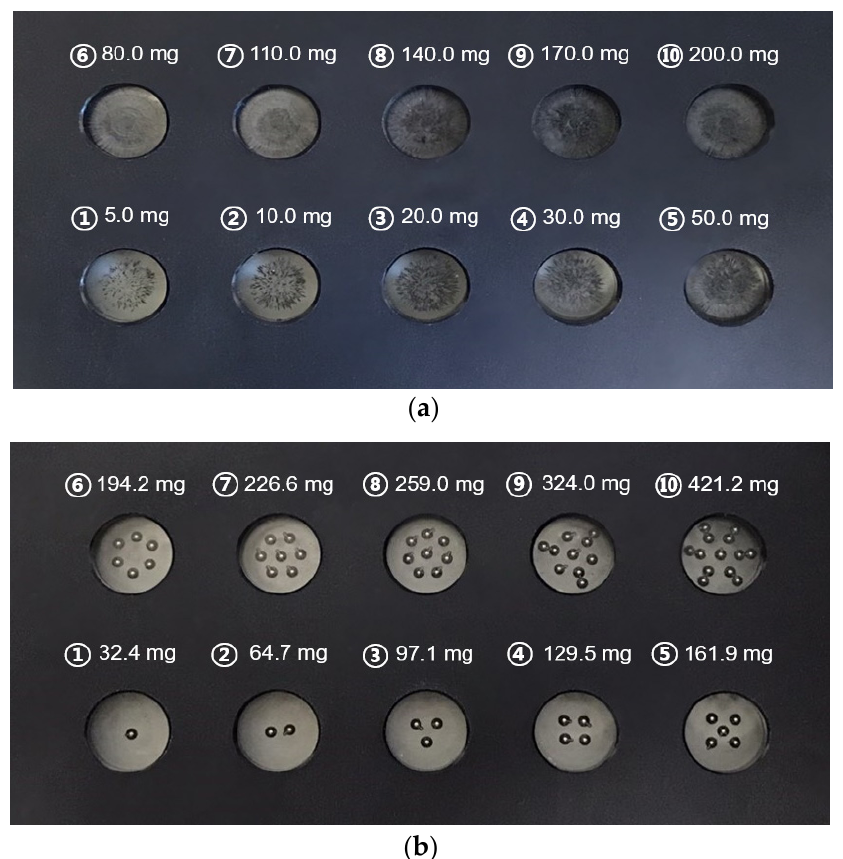
Figure 6. Standard specimens of the ferrous particles: ( a ) Fine particles; ( b ) Coarse particles.